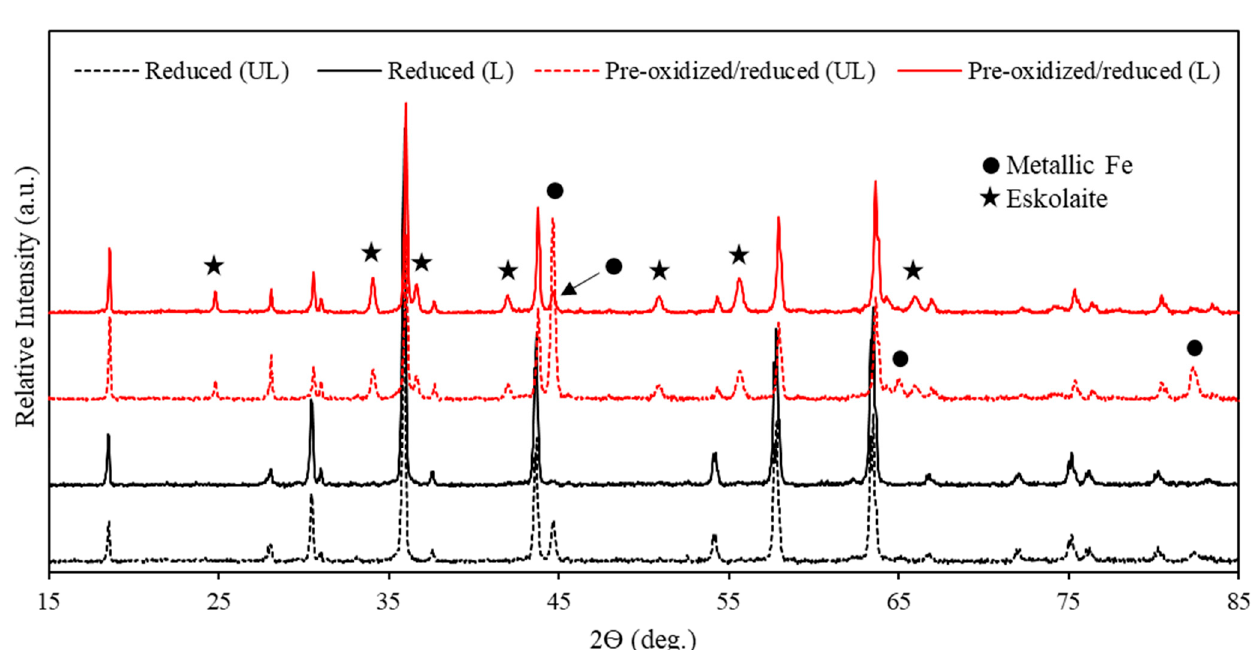
Figure 11. XRD patterns of leached (L) and unleached (UL) reduced and pre-oxidized/reduced samples. Pre-oxidation was performed at 1100 °C for 60 min and reduction was performed at 1100 °C for 60 min at a hydrogen flow rate of 750 mL/min.